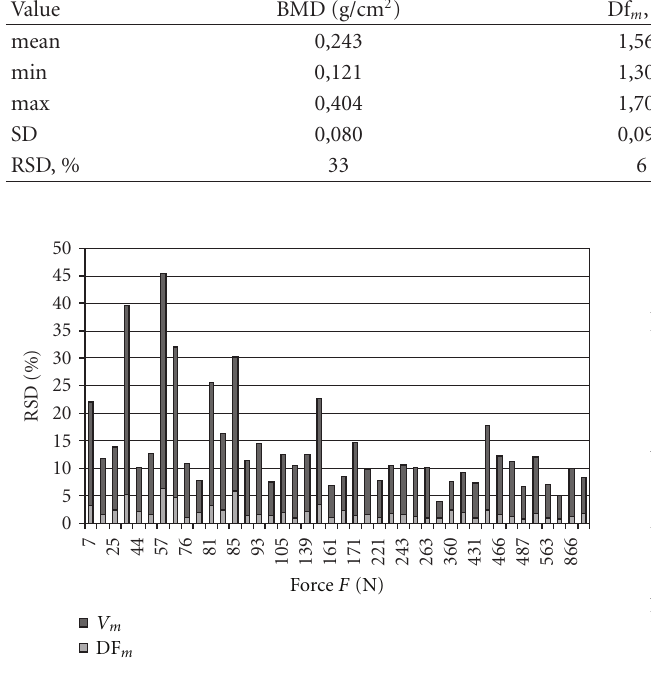
Figure 3: Values of RSD for Df m and V m